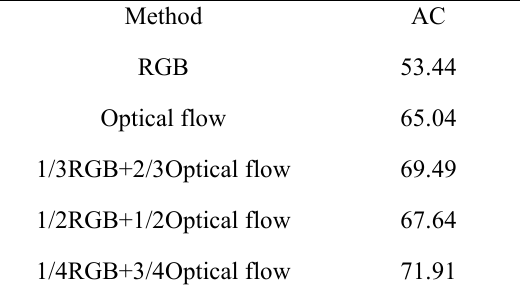
Table 1. Comparison of recognition accuracy(AC)